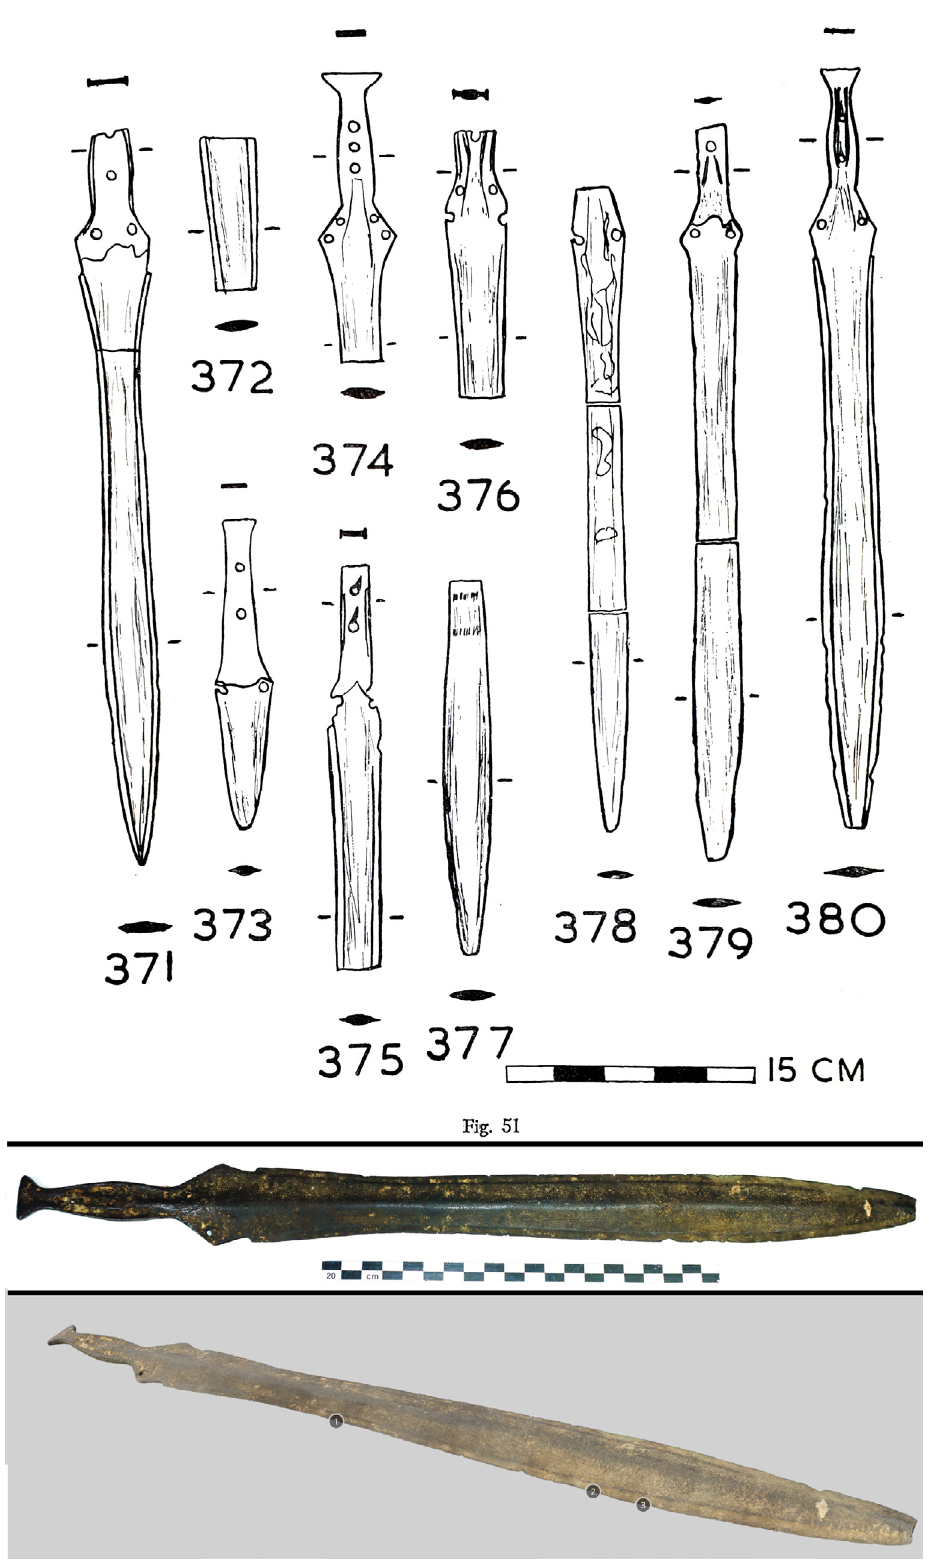
Figure 1. Late Bronze Age sword (NMI inventory #W 93) from Ireland: Comparison of published drawing in the context of other objects, conventional photograph and a 3D model. (Illustrations after Eogan, 1965, Fig. 51: 380, photography by B. Molloy and 3D model by M. Wisniewski and B. Molloy. Images and models generated from images taken by kind permission of the National Museum of